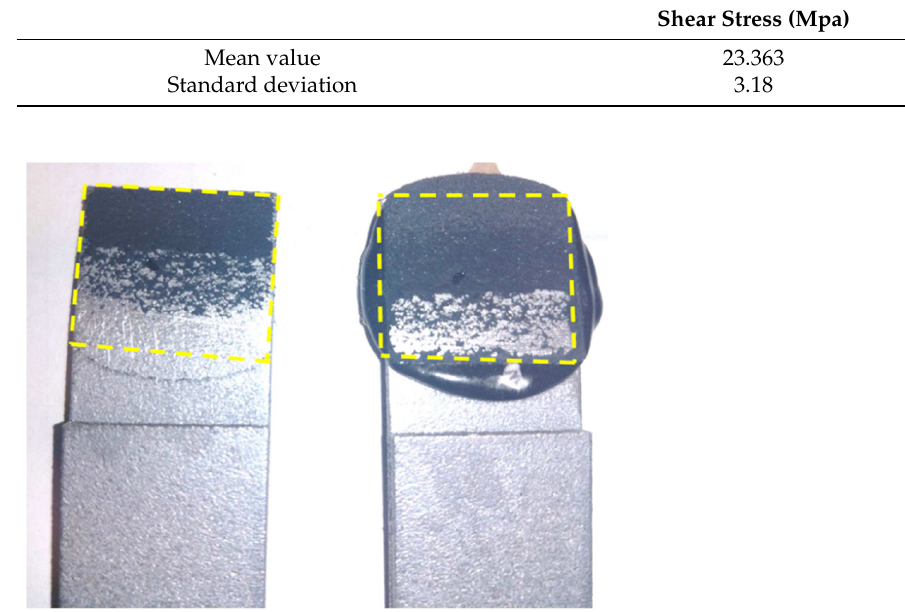
Figure 12. View of the joint after the shear force test. Table 7. Results of shear stress for all samples (the complete set of results are available in the Ap- pendix in Table A5).